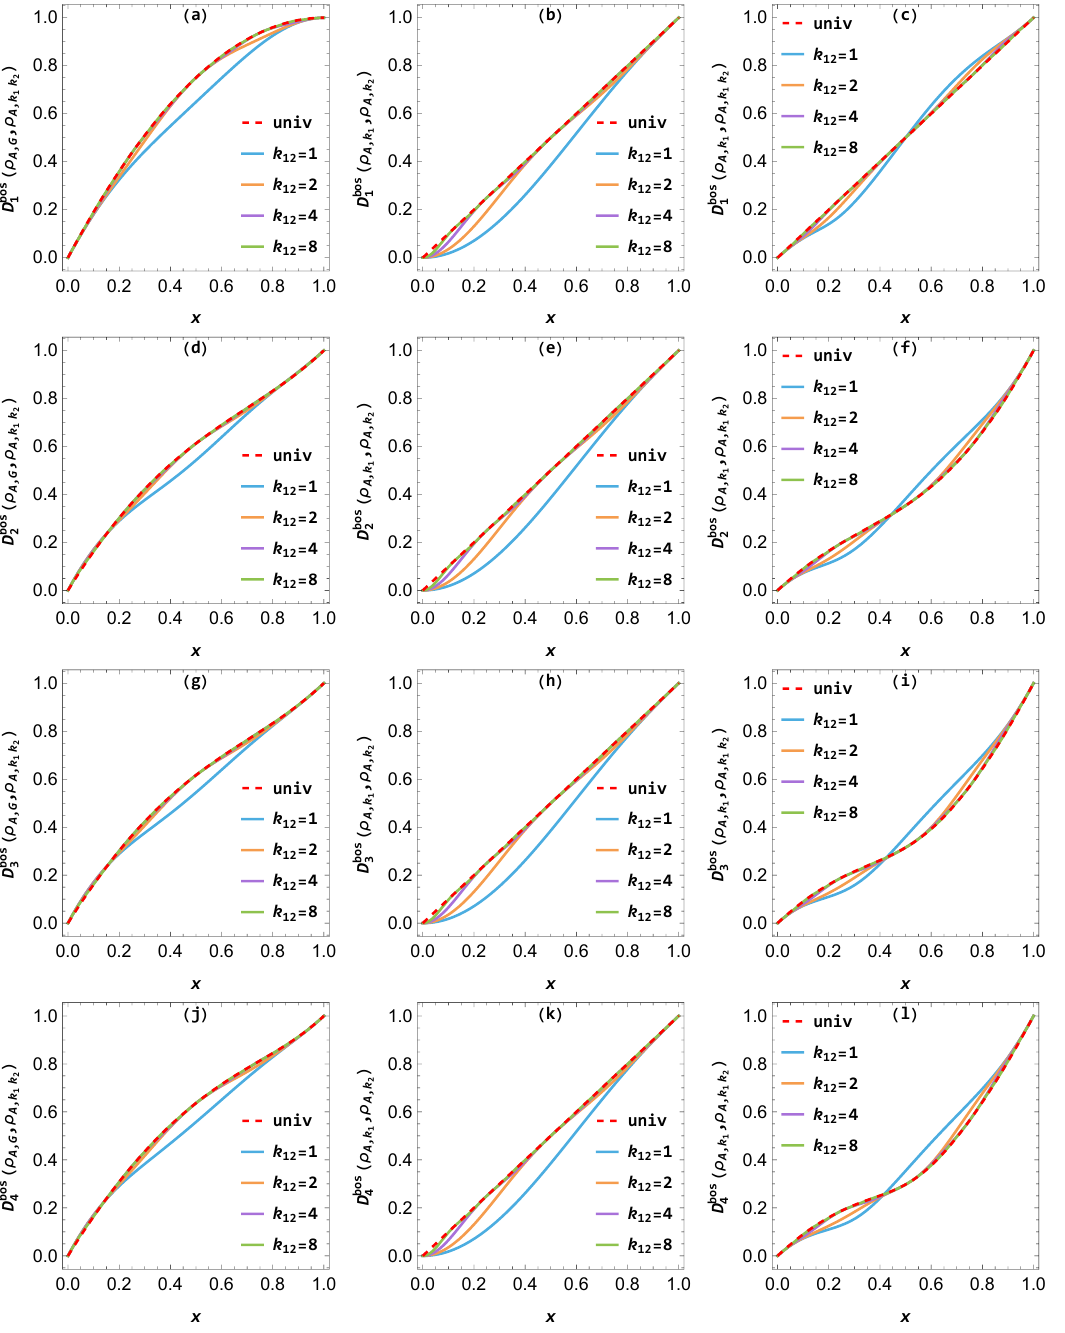
Figure 5 . The universal Schatten and trace distances from the semiclassical quasiparticle pic- ture (3.59), (3.60), (3.62), (3.65) and (3.66) (dashed red lines) and the analytical Schatten and trace distances from the subsystem mode method (5.34), (5.35), (5.36), (5.37) and (3.64) (solid lines) in the free bosonic chain. We use different colors to denote different quasiparticle momentum differences k . We have fixed L = + ∞ 12 ≡ k 1 − k 2